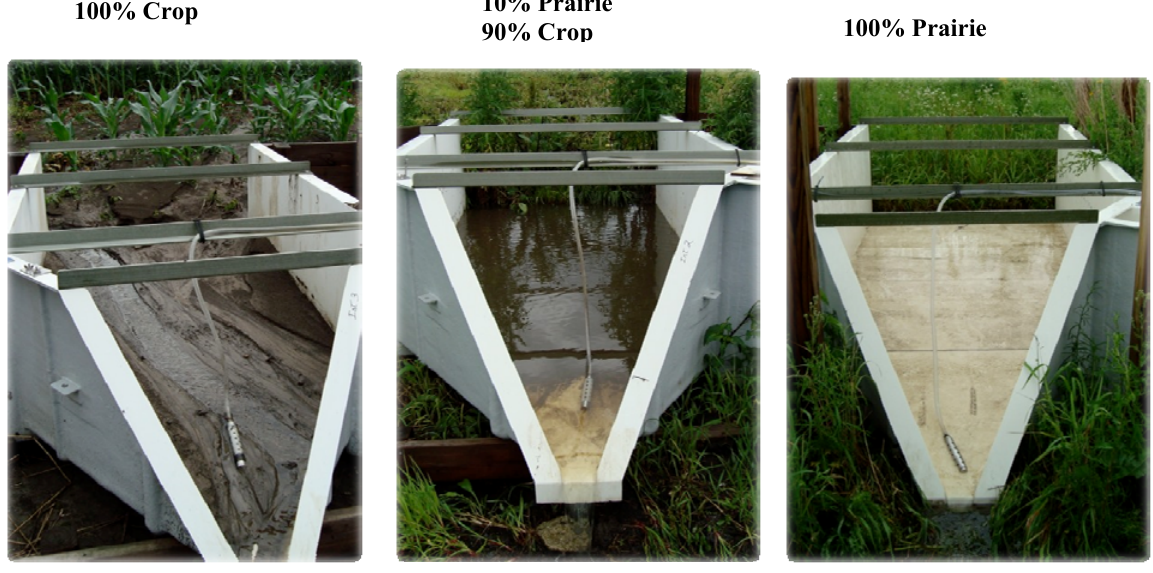
Figure 7. Visual examples of sediment loss from three small catchments in Walnut Creek watershed after a 4-inch rainfall event in June 2008. The 10% prairie catchment had reconstructed prairie planted at the catchment outlet. Photograph courtesy of M. Helmers (Photograph compilation courtesy of Dr. Matthew Helmers, Iowa State